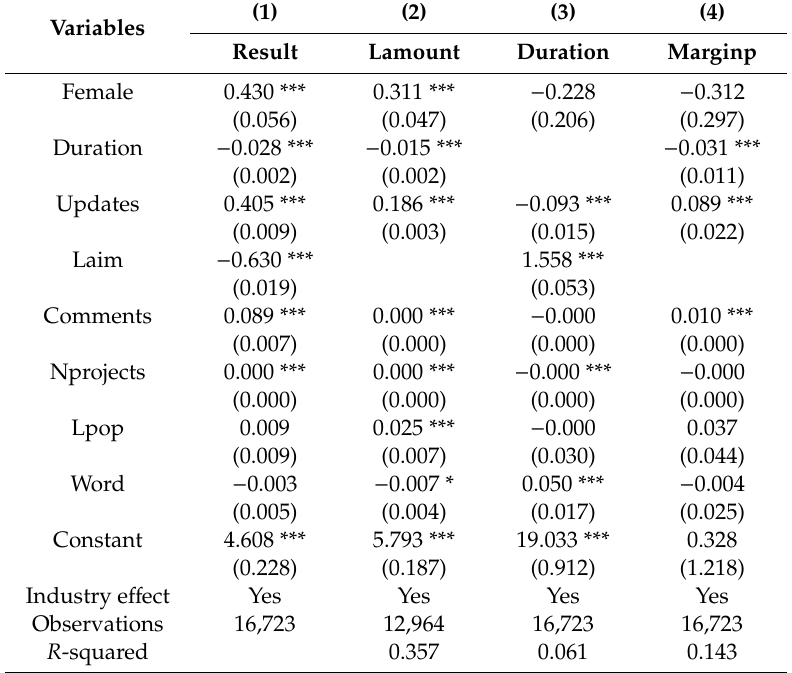
Table 12. Gender of initiators. This table reports results of regression analysis of the success, amount raised, duration, and margin (%) variables when the initiator is an individual. We controlled for di ff erent variables. Table 3 defines all the